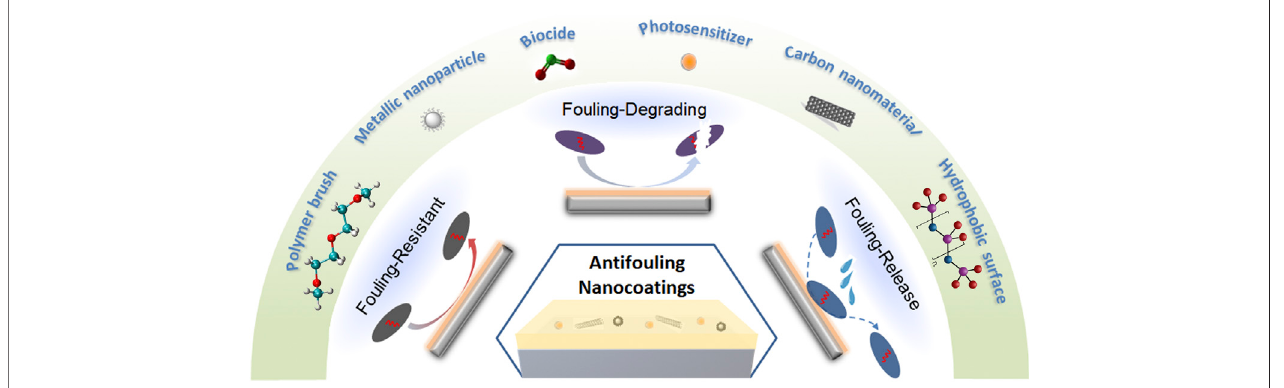
FIGURE 1 | Schematic illustration of the principal strategies and active ingredients in coatings for antifouling.